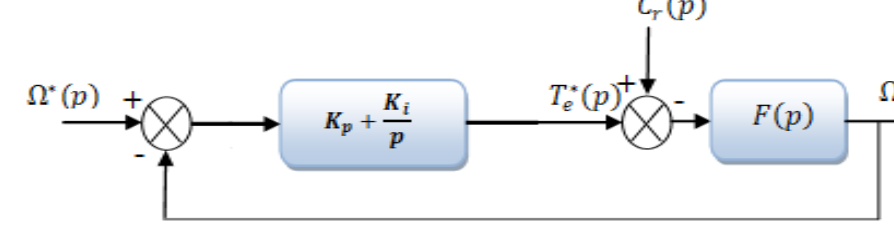
Figure 10. Closed loop PI speed controller.